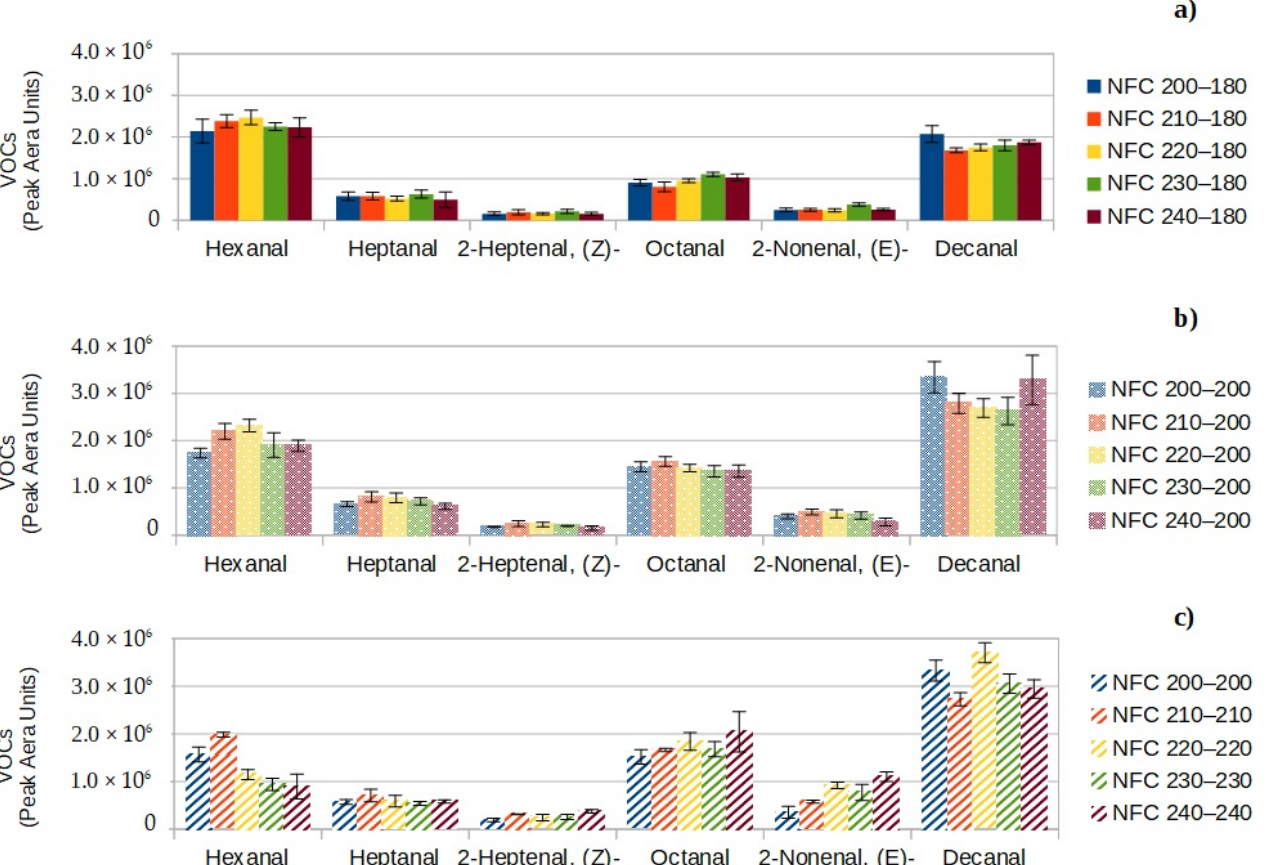
Figure 4. VOCs coming from lipophilic extractives of flax fibers: aliphatic and unsaturated aldehydes as a function of molding temperature conditions for a core temperature of ( a ) 180 ◦ C, ( b ) 200 ◦ C and ( c ) going from 200 ◦ C to 240 ◦ C.